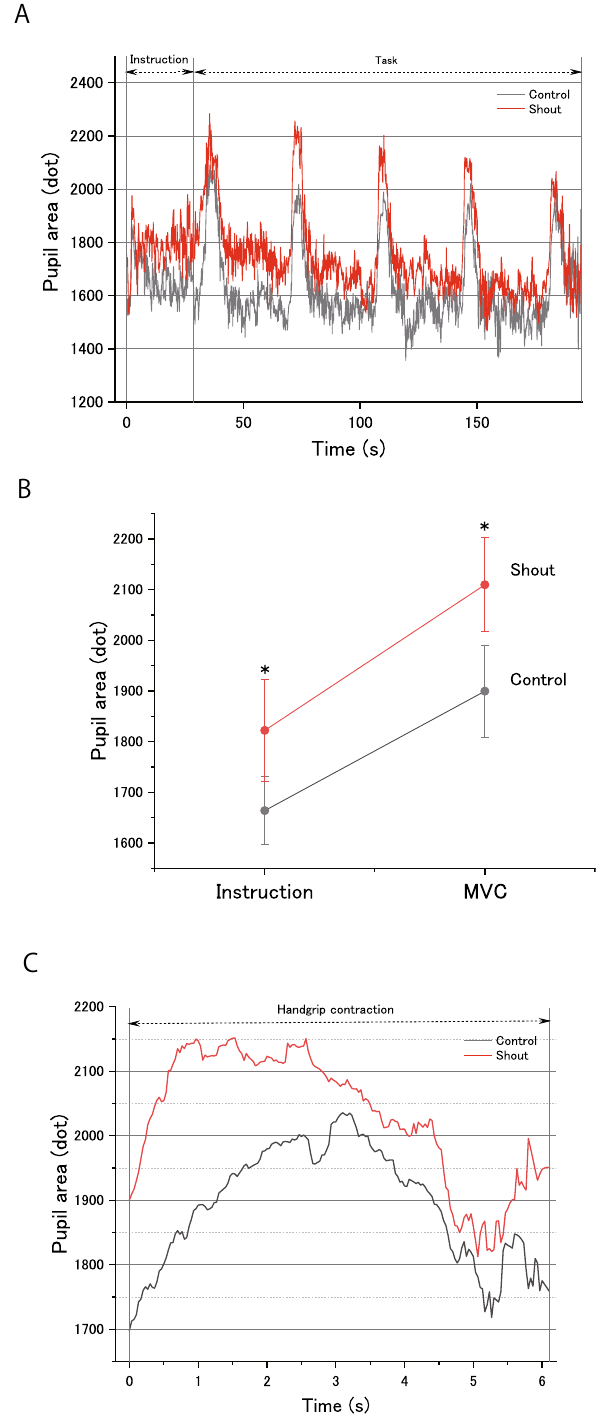
Figure 5. Effects of shouting on pupil area over time. (A) Pupil area (dots) starting at the onset of word presentation in the experimental procedure and lasting until the end of the maximal voluntary contraction force (MVC) task. Pupil area is expressed as the mean for each experimental condition (control or shout). The data were low-pass filtered with a cut-off frequency of 1 Hz using a fourth-order Butterworth filter. Two bidirectional arrows ( ↔ ) indicate the period of the experimental instruction and the period of the MVC handgrip task, respectively. Instruction: experimental instruction phase. Task: MVC task phase. Pupil area (dots) is expressed as the mean during the period of the experimental instruction phase and during MVC (not during the MVC task phase) for each experimental condition (control or shout). (B) Pupil area (dots) during the period of the experimental instruction phase and during each number of squeezing a handgrip device displayed for 5 s (not during the MVC task phase) for the two experimental conditions (control or shout). (C) Averaged pupil area (dots) during squeezing a handgrip device displayed for 5 s for the two experimental conditions (control or shout). The shout condition resulted in a greater pupil area compared with the control condition. However, the result does not necessarily guarantee that the pupillary dilation by shouting causally related to the MVC enhancement: it could reflect that the pupil diameter just responded to shouting and MVC. Pupil area data (A,B) are expressed as the mean ± standard error of the mean. * P < 0.05, vs. control